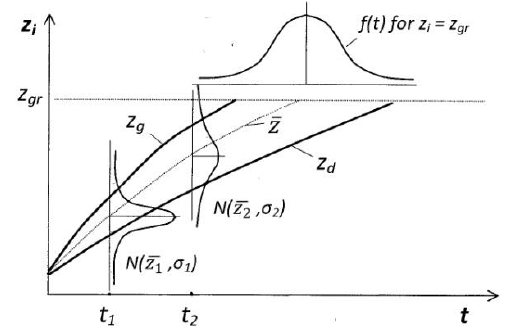
Fig. 5. Graphic interpretation of mathematical model of wear process of the cylinder